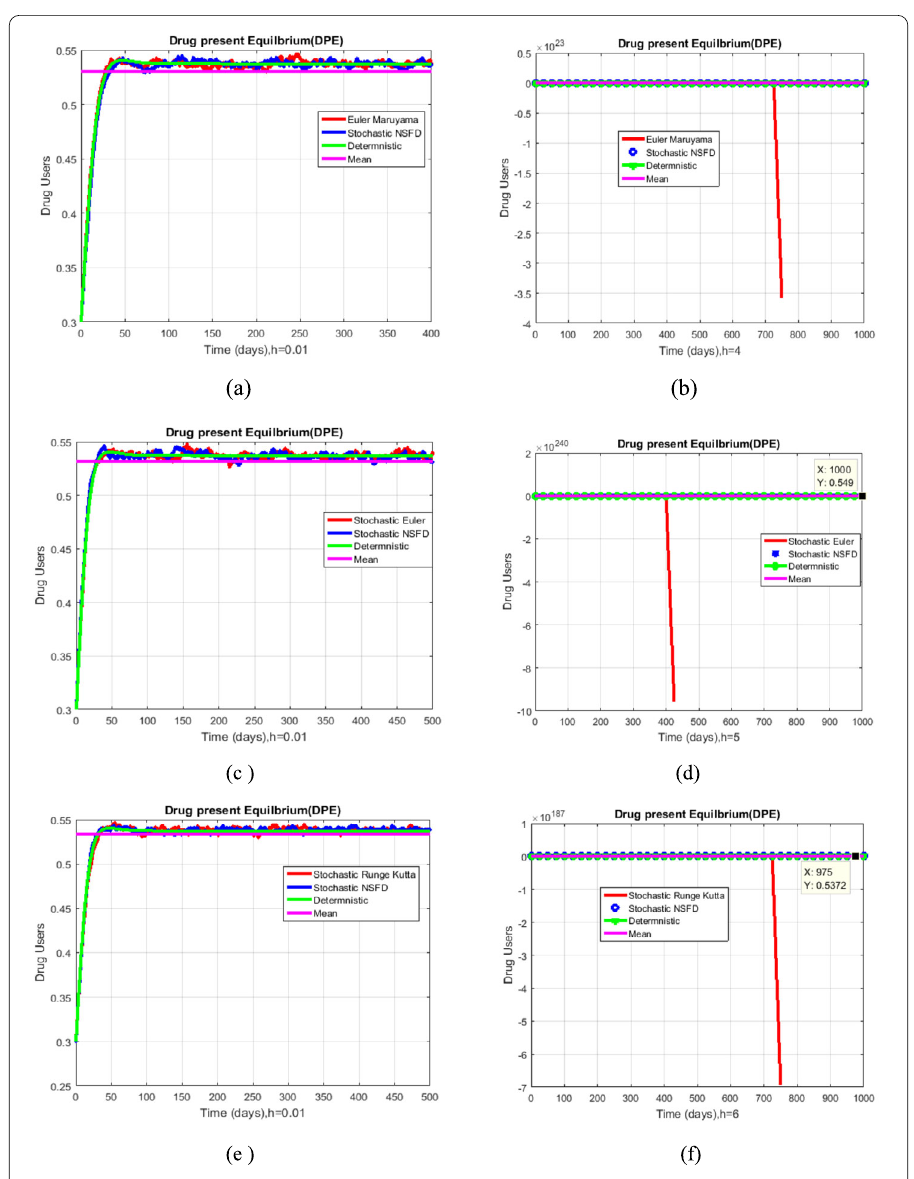
Figure 6 ( a ) Drug users’ fraction with Euler–Maruyama and its average at h = 0.01. ( b ) Drug users’ fraction with Euler–Maruyama and its average at h = 4. ( c ) Drug users’ fraction with stochastic Euler and its average at h = 0.01. ( d ) Drug users’ fraction with stochastic Euler and its average at h = 5. ( e ) Drug users’ fraction with stochastic Runge–Kutta and its average at h = 0.01. ( f ) Drug users’ fraction with stochastic Runge–Kutta and its average at h = 6